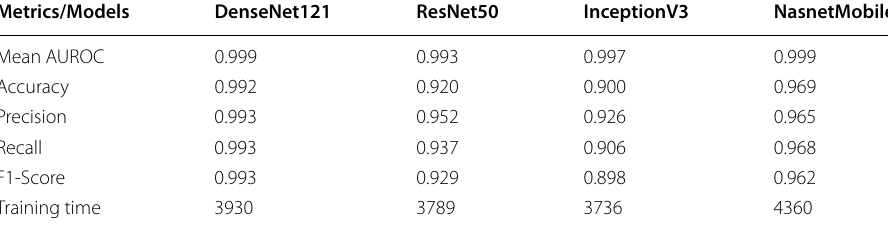
Table 1 Model Evaluation